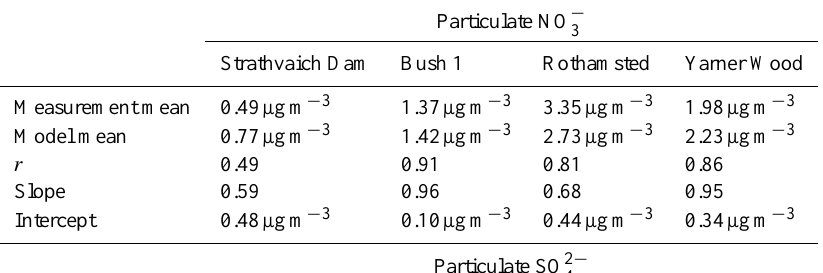
and SO 2 − in 3 4